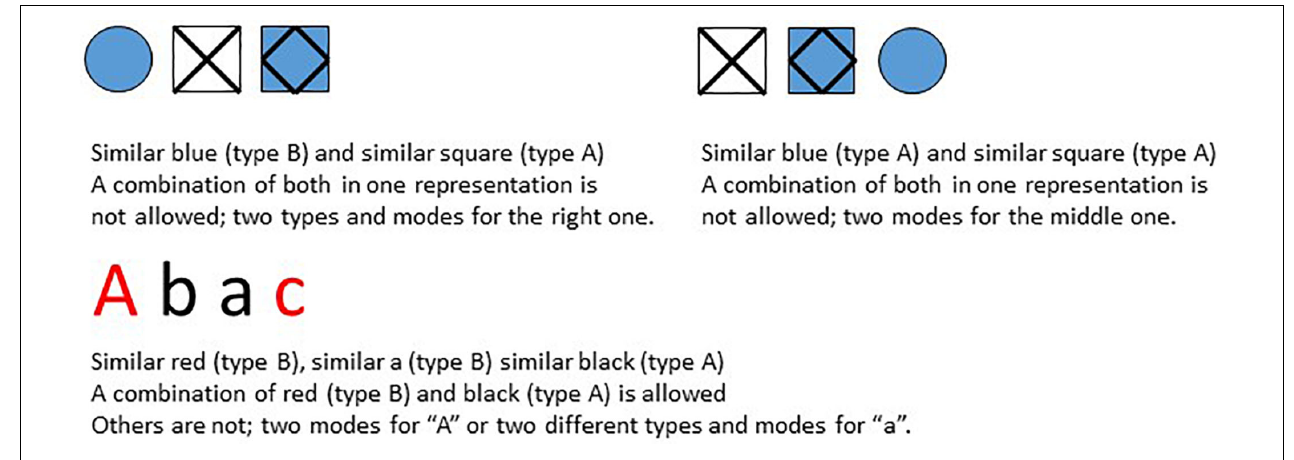
FIGURE 6 | Types of modes and